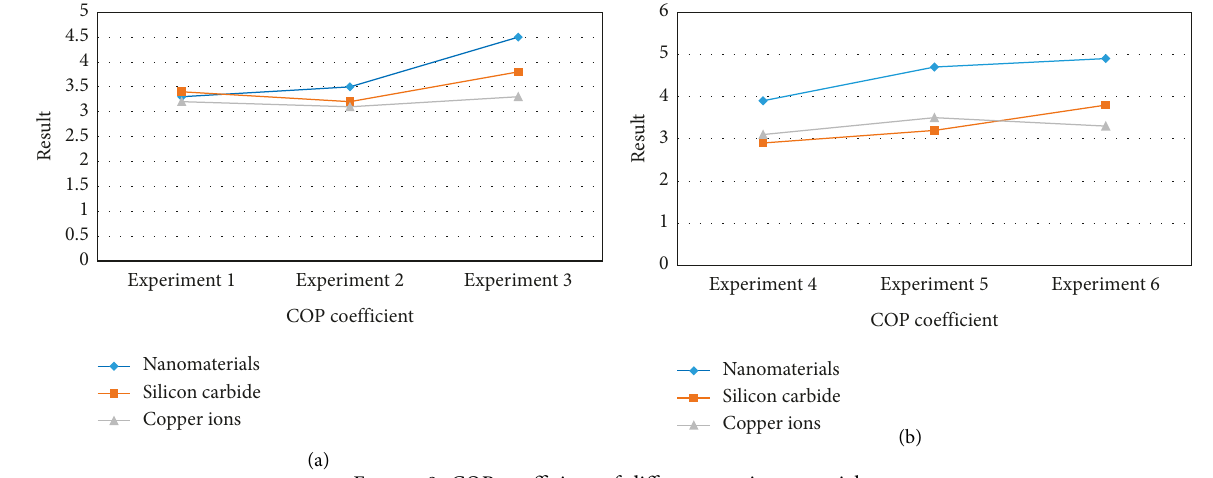
Figure 9: COP coefficient of different coating materials.